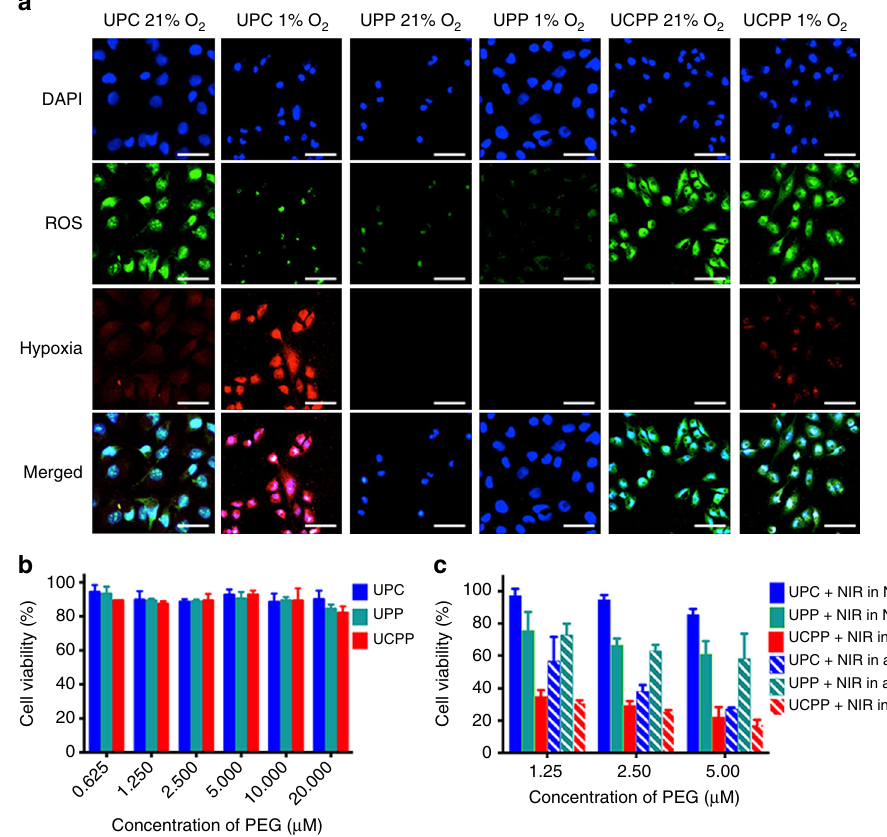
Fig. 3 In vitro study of oxygen generating, PDT enhancement and cytotoxicity. a CLSM images of PDT-induced hypoxia reversion and intracellular ROS generation. The scale bars represent 20 μ m. b Relative viabilities of L929 cells after incubation with various concentrations of UPC, UPP or UCPP without light irradiation for 48 h. c Relative cell viability of UPC-, UPP- or UCPP-treated HeLa cells under 980 nm light irradiation (5 min per every well) in hypoxic and normoxic environments. Data were shown as mean ± S.D. ( n =